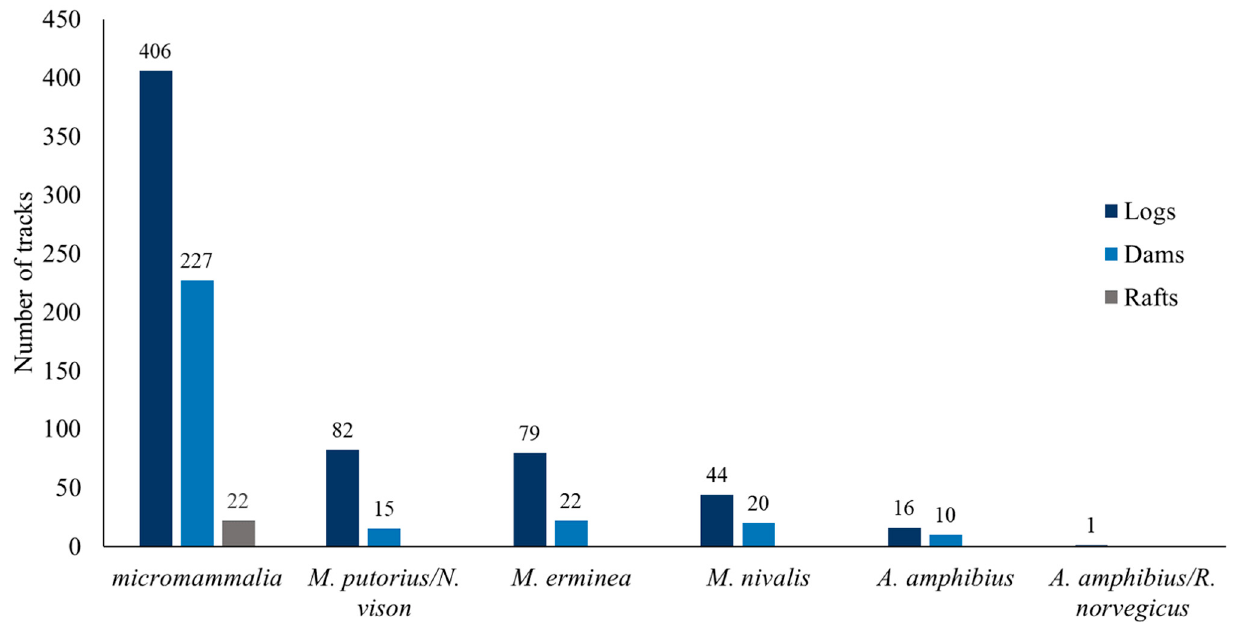
Figure 6. Unadjusted activity of particular mammalian taxa recorded in each category of tracking tunnel location—comparison of taxonomic composition (all sites and points combined).